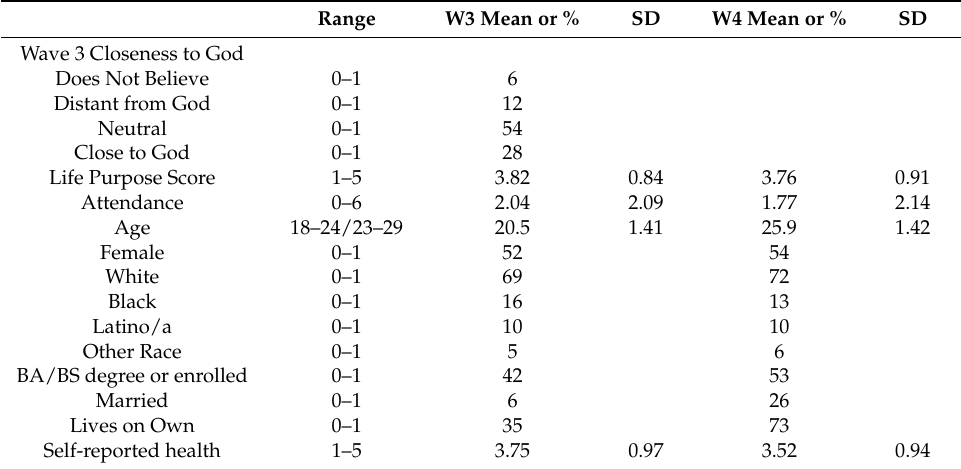
Table 1. Descriptive Statistics, National Study of Youth and Religion (NSYR) Wave 3 and Wave 4. Range W3 Mean or % SD W4 Mean or % SD Wave 3 Closeness to God Does Not Believe